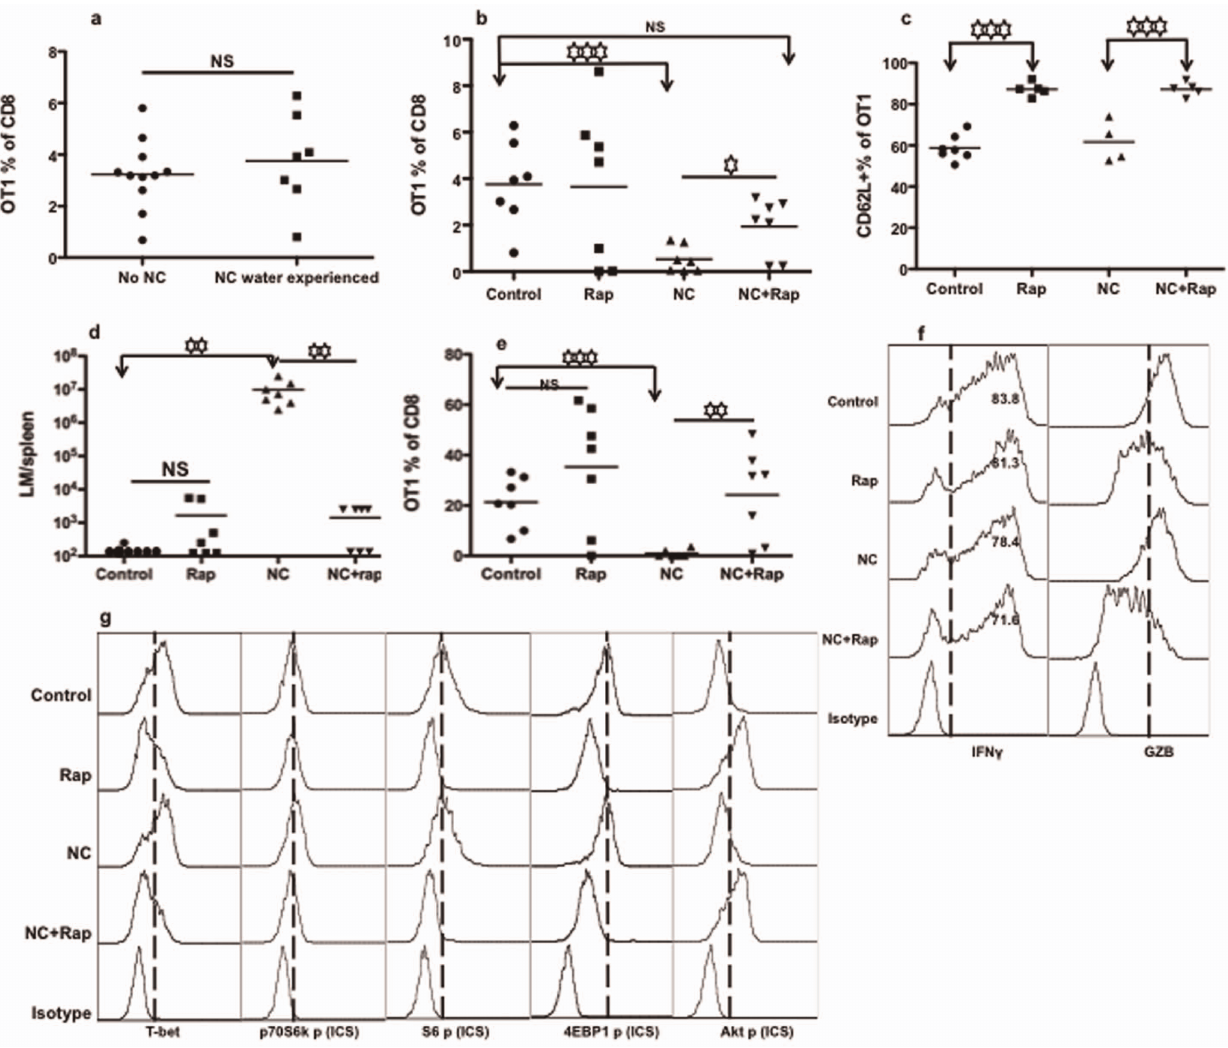
Figure 7. Chronic exposure to nicotine does not change naı¨ve CTL’s memory programming. OT-I transgenic mice were given drinking water supplemented with nicotine at 200 m g/ml for 60 days [34,37–39]. Naı¨ve OT-I cells were purified from the nicotine treated OT-I mice or un- treated control mice and stimulated for 3 days with 3SI in the presence or absence of nicotine at 10 m M. Rapamycin was used with or without nicotine. Cells were then harvested for adoptive transfer at a concentration of 10 6 cells/mouse for memory differentiation in recipient B6 mice [22,24,25] (A–E) or direct examination (F–G). A–C. Analysis of memory CTLs 30 days after transfer. A. Comparison of memory CTLs in blood programmed in vitro by IL-12 from control or nicotine experienced OT-I mice. B. Comparison of memory CTLs in blood programmed under different treatments. All of the naı¨ve OT-I CTLs were from nicotine treated donor mice. Data for ‘‘NC water experienced’’ in (A) are the same as ‘‘Control’’ in (B). C. CD62L expression on memory CTLs from blood in (B). D. Memory mice from (B) were challenged with LM-OVA, and protection was compared 3 days after challenge in spleen. E. Memory CTL secondary expansion in the blood 3 days after LM-OVA challenged (the same mice in D) mice. F–G. In vitro stimulated cells (for 3 days) were harvested to examine the production of functional molecules (F) or transcription factors and mTOR signaling molecules (G). Data from one experiment is shown, representative of two other experiments with similar results. Asterisks indicate statistical significance. *, P , 0.05; **, P , 0.01; ***, P , 0.001, NS, not